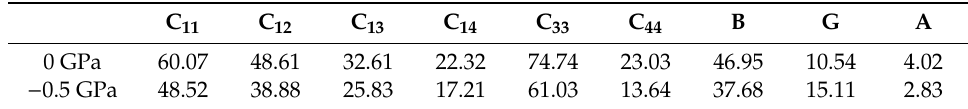
Table 3. Calculated elastic constant, Bulk modulus (B), Shear modulus (G), and elastic anisotropy (A) of CsGeI 3 under the pressure of 0 GPa and − 0.5 GPa.